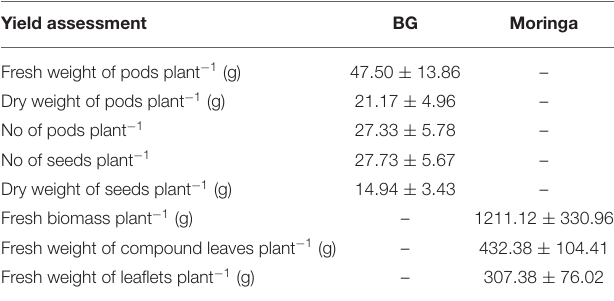
TABLE 1 | Yield (with standard error) of BG and moringa